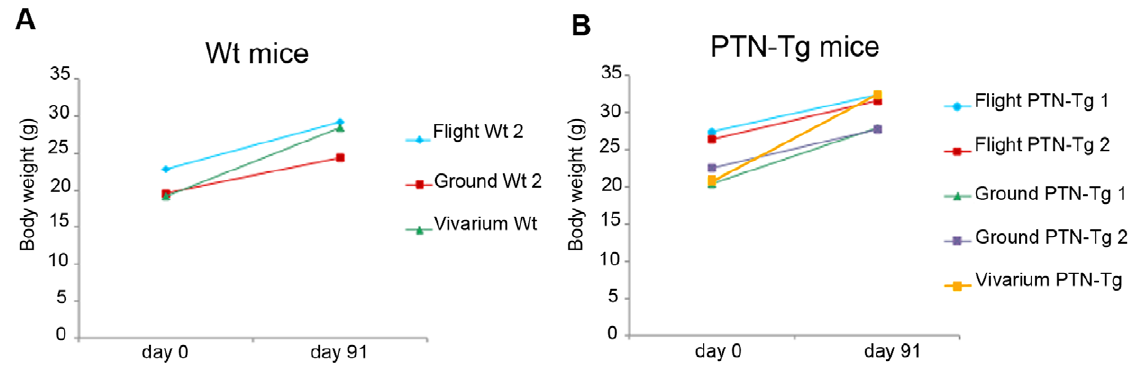
Figure 2. Body weight. Body weight increase of the flight mice and of the ground and vivarium control mice during the 91-day MDS experiment. Panel A): Wt mice; Panel B): PTN-Tg mice.